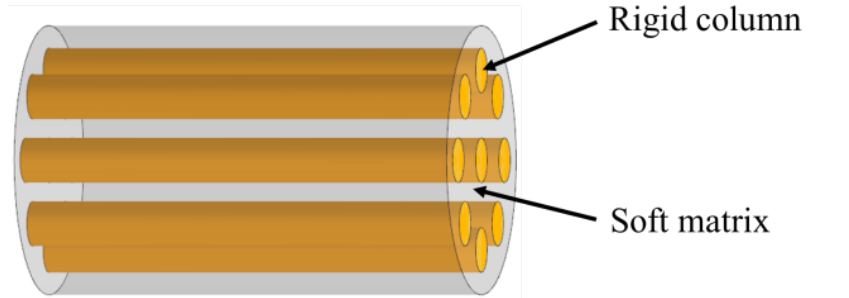
Figure 3. Schematic diagram of the columnar model.